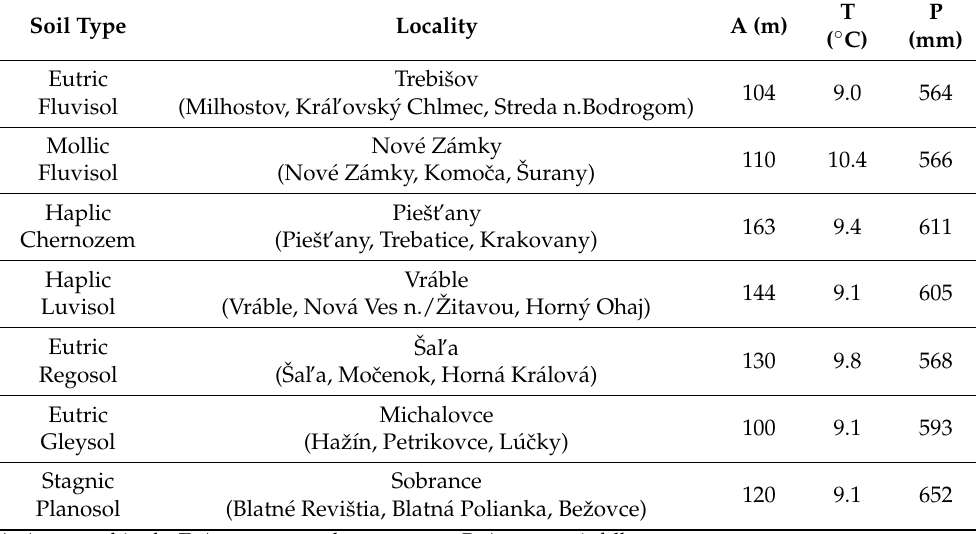
Table 1. Soil sampling locations.